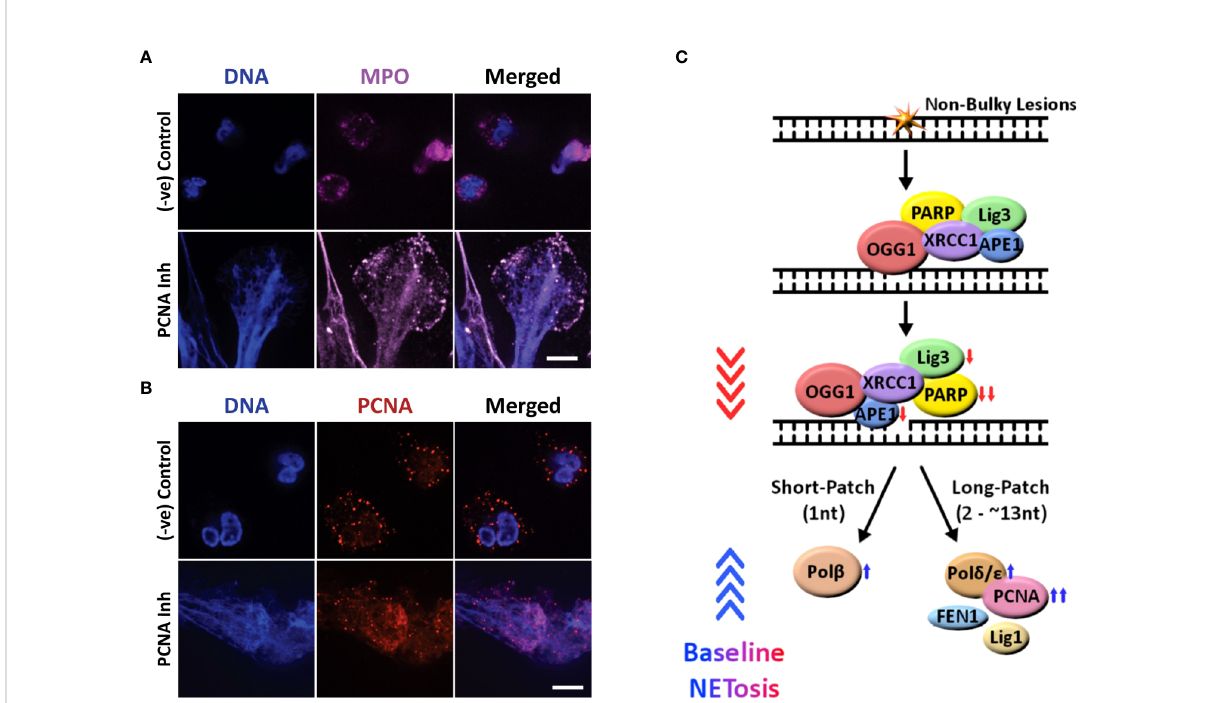
FIGURE 2 Confocal images showing that inhibiting the late stage oxidative DNA damage repair pathways induce spontaneous NETosis, and a diagram summarizing the regulation of spontaneous NETosis by various DNA repair proteins. (A, B) Neutrophils were treated with PCNA inhibitor (T2AA), immunostained and imaged by confocal microscopy. MPO (pink) colocalizing to DNA (DAPI blue) shows that PCNA inhibition promotes spontaneous NETosis (A) . PCNA (red) is cytoplasmically distributed in the neutrophils but the inhibition of late stage DNA repair by inhibition of PCNA: polymerase binding leads to NETosis with PCNA present throughout the NET DNA (DAPI, blue) (B) . Images for panels are representative of 3 independent experiments. Scale bar, 10 m m. (C) Diagram highlighting the proteins involved in the oxidative DNA damage repair pathways and their effects on spontaneous NETosis. Non-bulky adducts are repaired by BER. Baseline NETosis is suppressed by early DNA repair events that lead up to the chromatin decondensation/nick formation by APE1. Inhibition of late events of DNA repair promotes spontaneous NETosis. Proteins whose inhibition induces ( , blue arrow) or suppresses ( , red arrow) spontaneous NETosis are indicated. Overall, inhibition of early and late steps of oxidative DNA damage repair pathway result in powerful inhibition ( , red arrowheads) and activation ( blue arrowheads) of spontaneous NETosis,